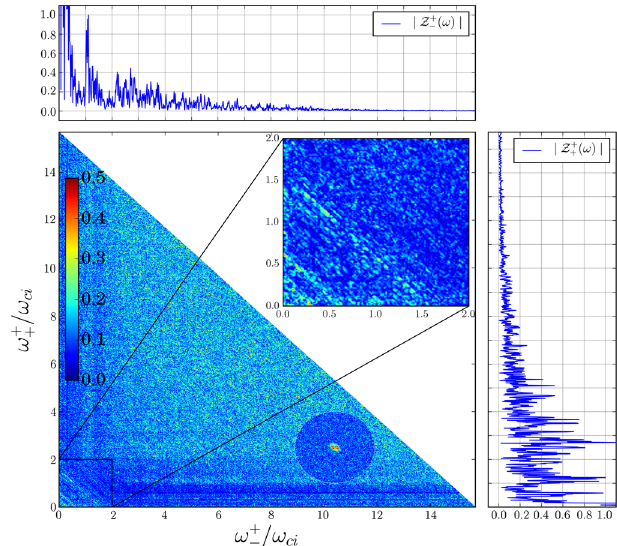
FIG. 10. Cross-bicoherence C LR resulting from the coupling between an ion-cyclotron wave and two counterpropagating whistler waves. For convenience, the modulus of the time Fourier transform of the generalized Elsässer fields normalized by their respective maximum value around ω ci ¼ 1 are also shown above and beside the plot. The intense signal surrounded by a circle of weaker signal corresponds to the fiducial bicoherence mentioned in the text. This gives an idea of the statistical noise inherent to the statistical ensemble that we consider, as well as the signature of quadratically phase-coupled